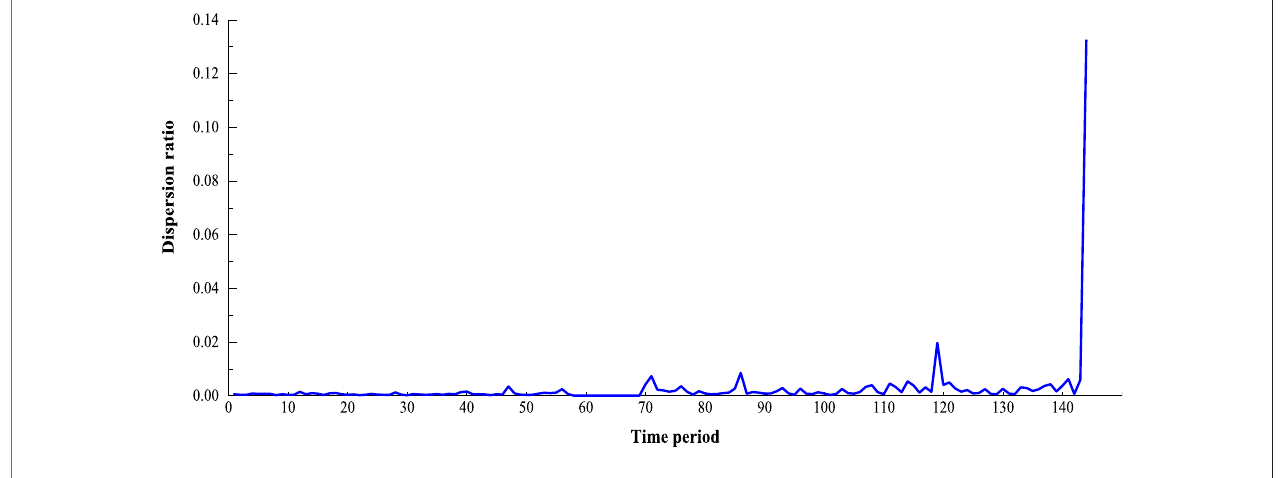
FIGURE 10 | Gas emission quantity dispersion ratio curve.